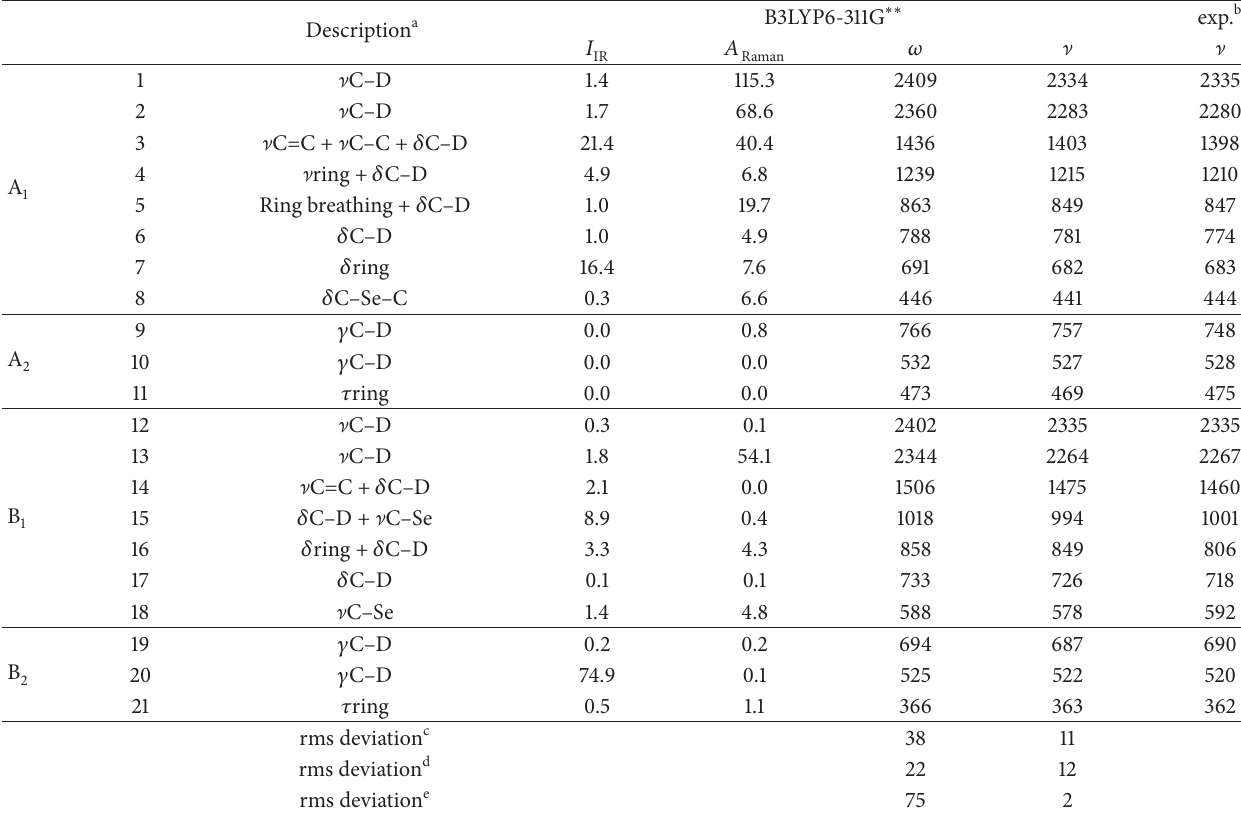
Table 3: Vibrational harmonic, 𝜔 , and anharmonic, ] , wavenumbers (cm − 1 ), infrared intensities, 𝐼 (˚A 4 /amu) of C D 4 4